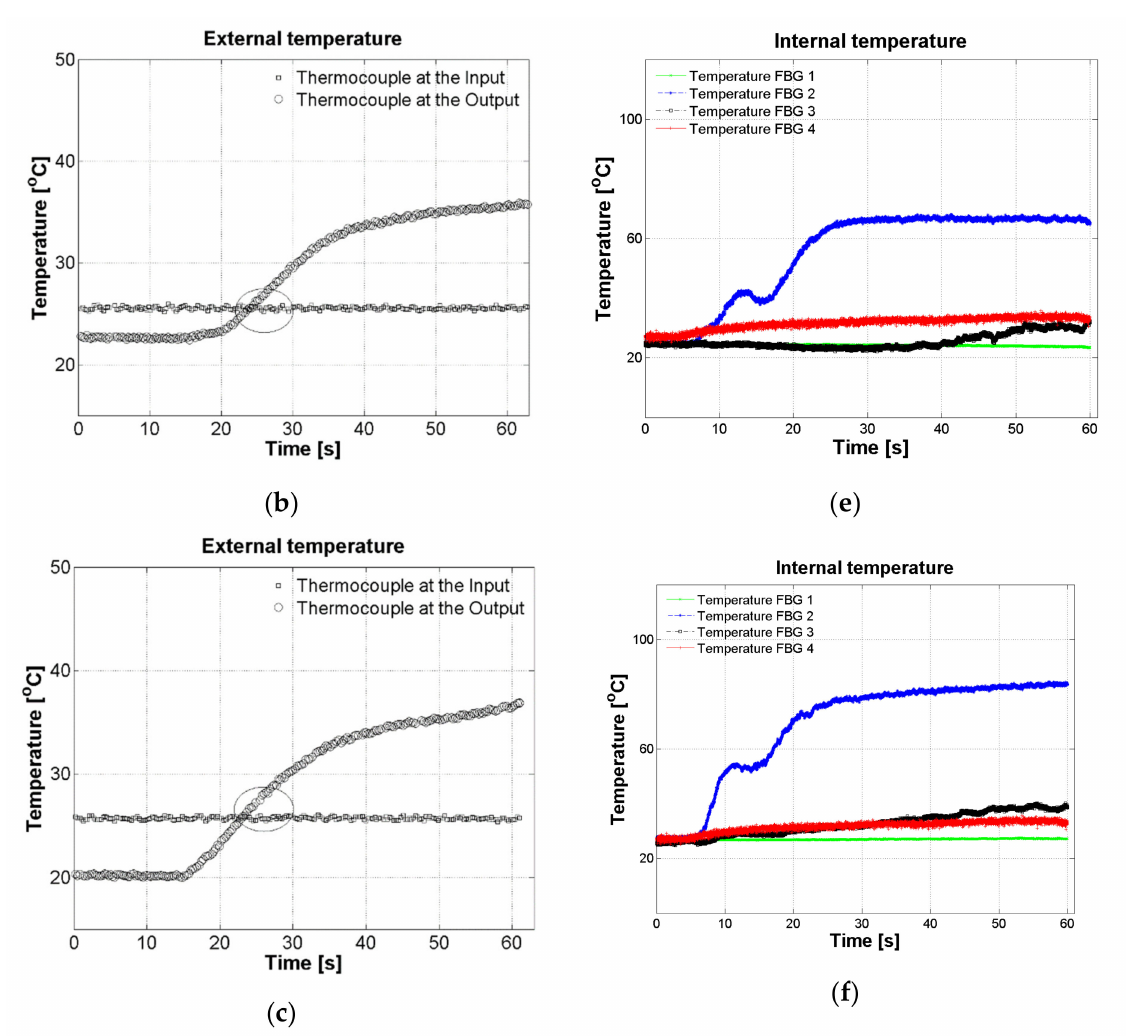
Figure 12. Temperature as function of time using water with dissolved salt and sugars. Outer temperatures measured by thermocouples in ( a ): 60 s, ( b ): 60 s, and ( c ): 60 s. Inner temperatures measured by FBG temperature sensors ( d ): 60 s, ( e ): 60 s, and ( f ): 60 s. Blue and black lines indicate FBG 2, 3 and 4 in contact with the water. Green line indicates FBG 1 the temperature inside the microwave